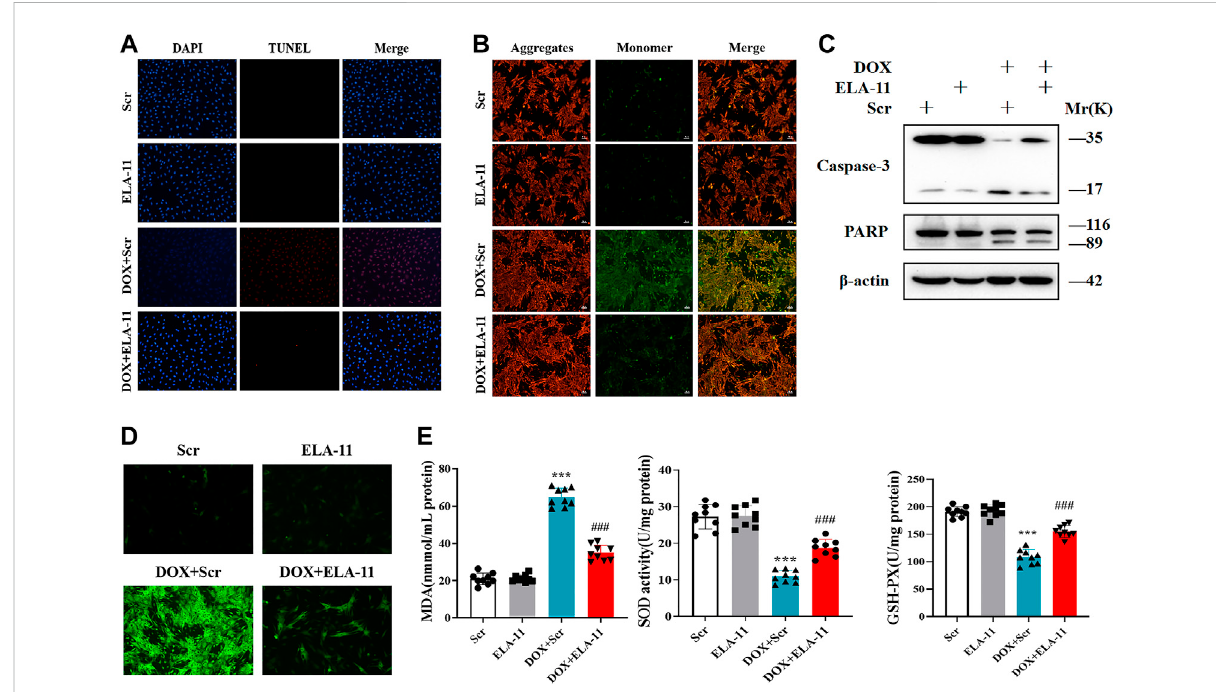
FIGURE 4 ELA-11 inhibits DOX-induced cardiac injury through oxidative stress -induced apoptosis. (A) Representative photographs of TUNEL staining in DOX- induced cardiomyocyte injury (N = 9 per group). (B) Representative photographs of JC-1 in DOX-induced cardiomyocyte injury. (C) The expression ofPARP and caspase-3 inDOX-induced cardio-myocyteinjury bywestern blot. (D) Representative photographsofROS inDOX-induced cardio-myocyte injury. (E) Detection of MDA production, SOD activity and GSH-PX release in DOX-induced cardiomyocyte injury (N = 9